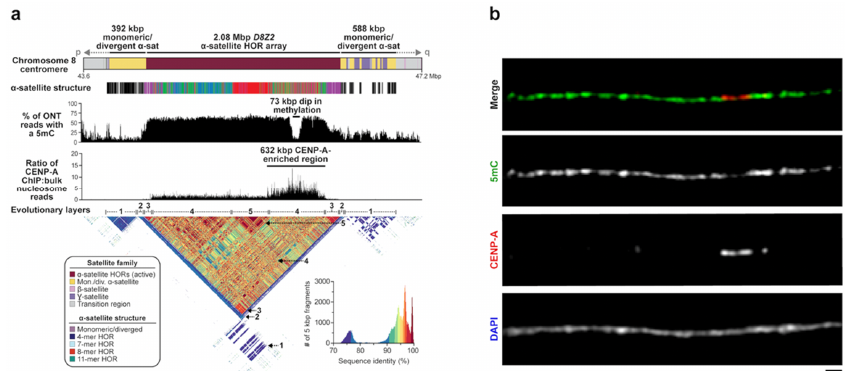
Figure 4. The site of kinetochore attachment within the chromosome 8 centromere. ( a ) Schematic showing the sequence composition, α-satellite structure, CpG methylation frequency, and CENP-A chromatin organization of the chromosome 8 centromere in the T2T-CHM13 genome. The D8Z2 α- satellite HOR array is 2.08 Mbp long and is generally methylated, except for a 73 kbp region enriched with nucleosomes containing the histone H3 variant CENP-A. CENP-A chromatin resides on struc- turally diverse α-satellite HORs. ( b ) Representative images of a CHM13 chromatin fiber showing CENP-A enrichment in a hypomethylated region. Scale bar, 1 μm. Adapted from [42].